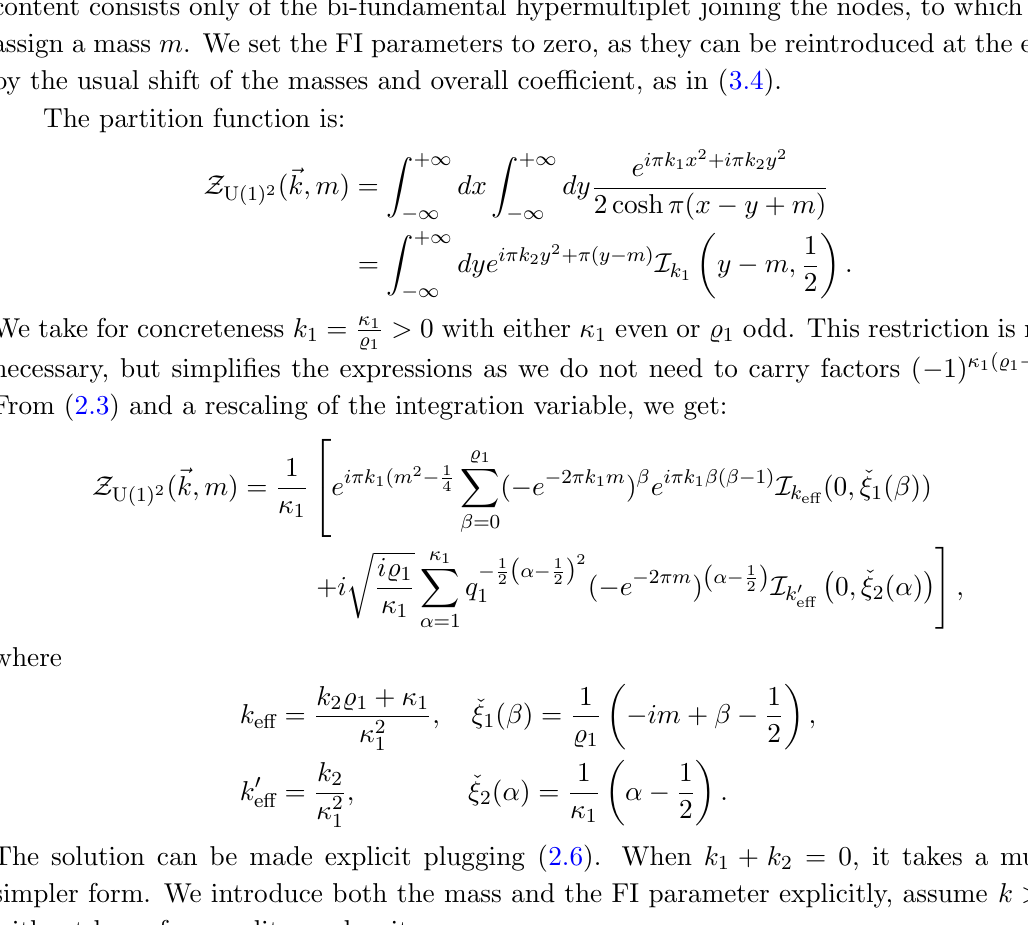
Figure 9 . Abelian A 2